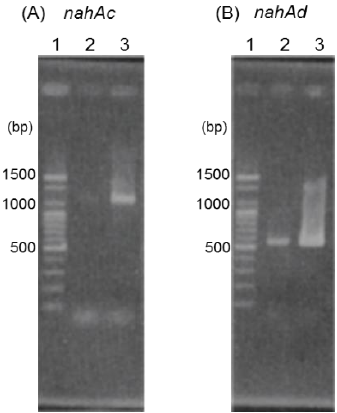
Figure 4. RT-PCR analyses using primer sets designed to amplify nahAc ( A ) and nahAd ( B ). Lane 1, 100 bp DNA ladder; lane 2, RNA extracted from strain JF8 grown on LB plate was used as template; lane 3, RNA extracted from strain JF8 grown on LB plate supplied with naphthalene as a vapor.